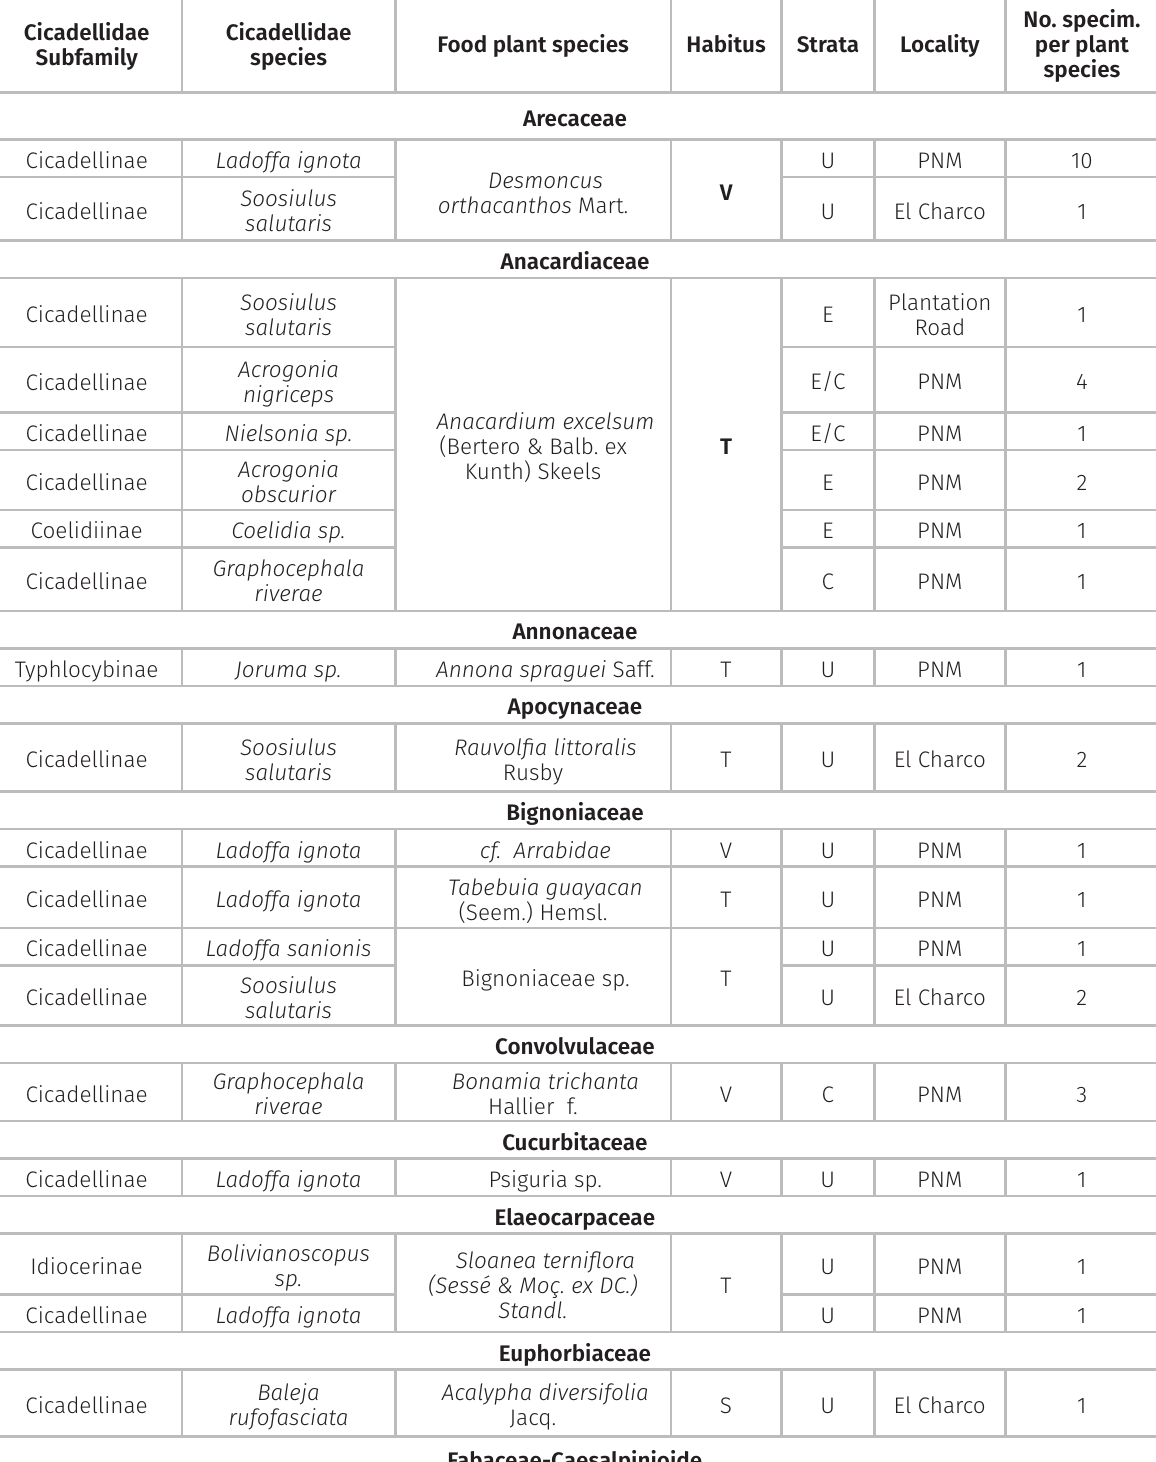
Table I. Food plants recorded of Cicadellidae species from Central Panama. Cicadellidae